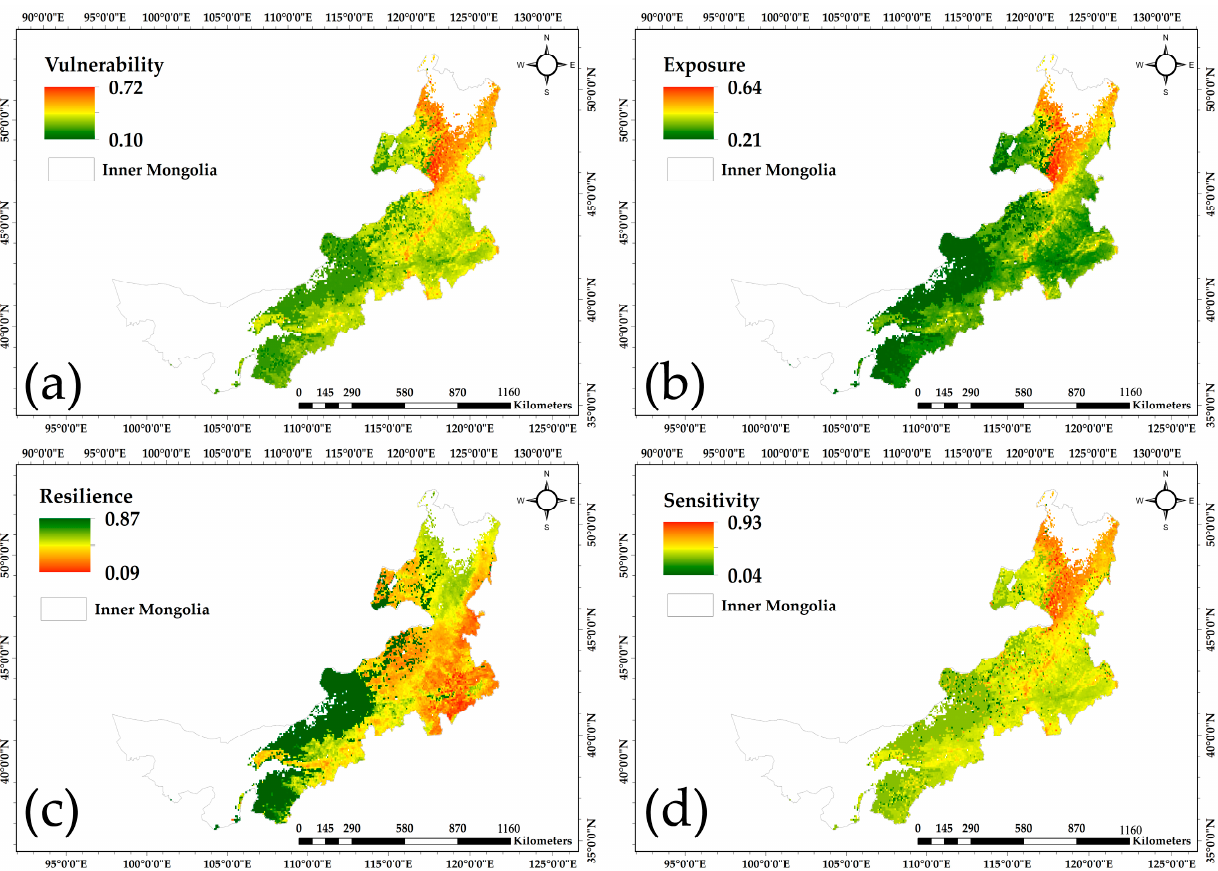
Figure 5. ( a ) Ecosystem vulnerability pattern; ( b ) ecosystem exposure pattern in Inner Mongolia; ( c ) ecosystem resilience pattern in Inner Mongolia; and ( d ) ecosystem sensitivity in Inner Mongolia. Blank areas represent no data areas. The color ramp of Figure 5a,b,d from red to green indicate stronger to smaller. The color ramp of Figure 5c from green to red indicate stronger to smaller.